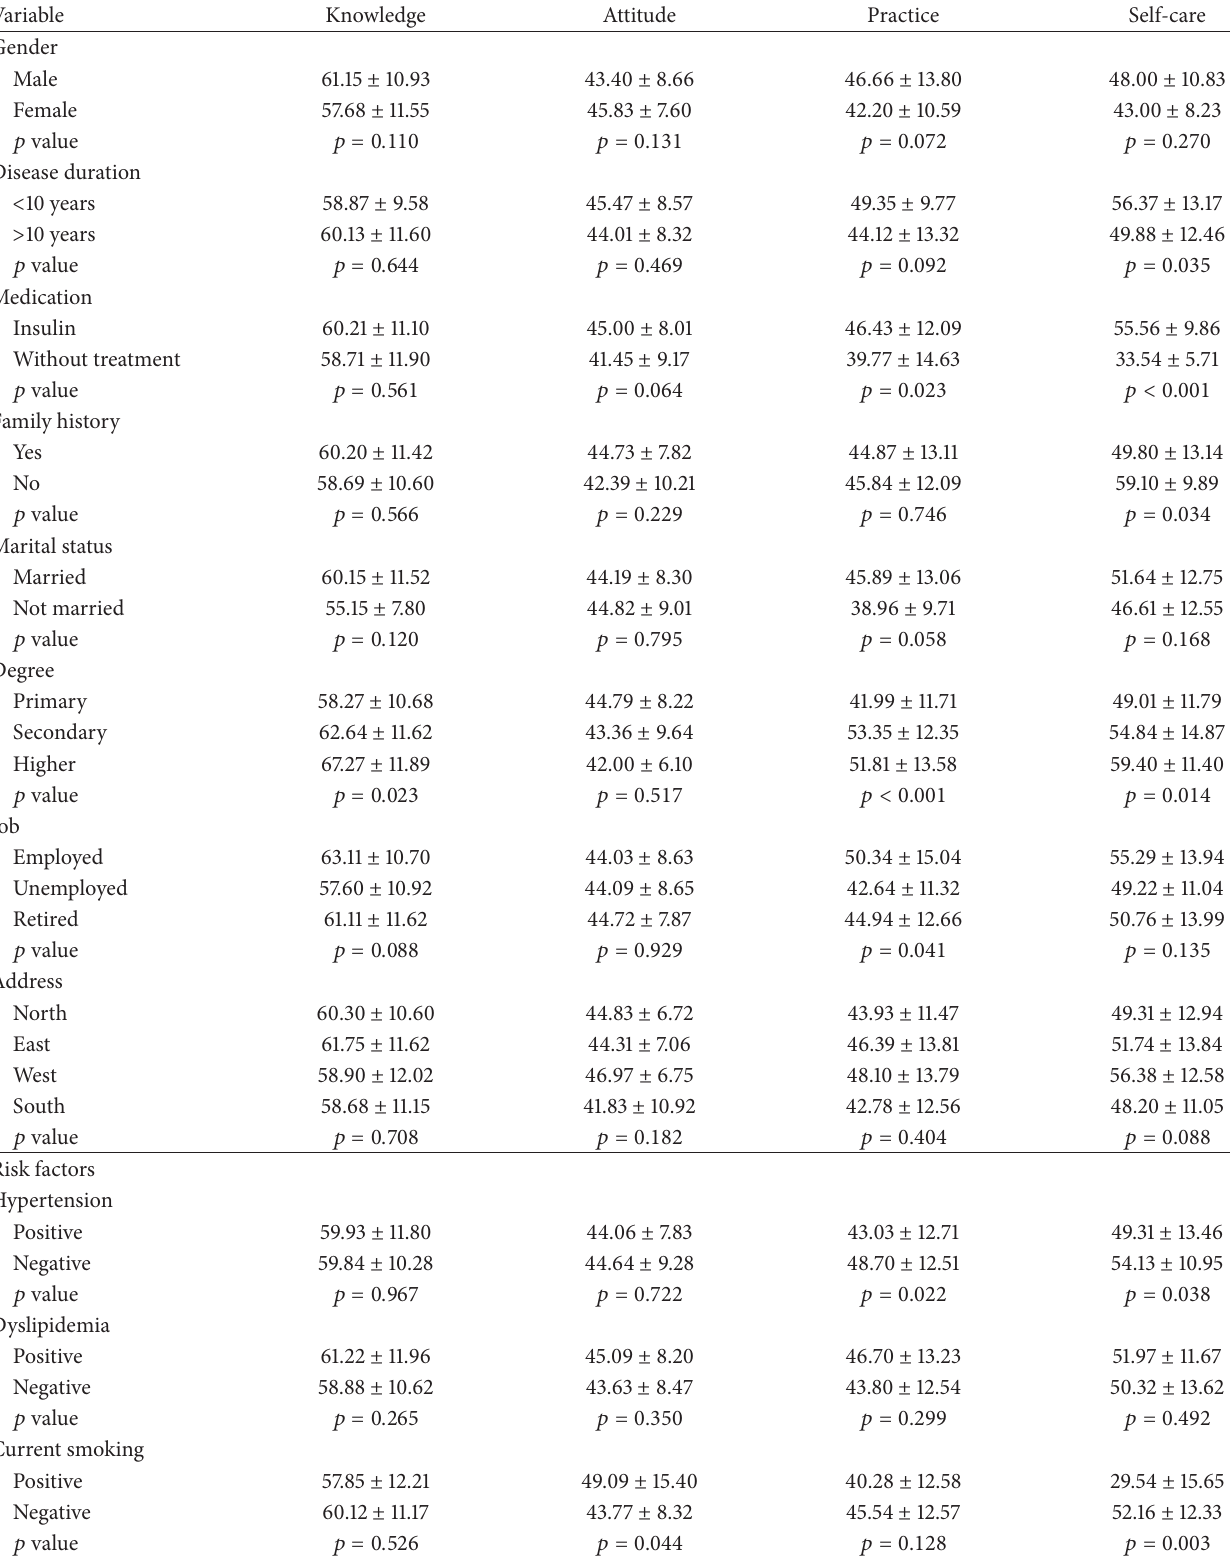
Table 2: Patients’ knowledge, attitude, practice, and self-care scores